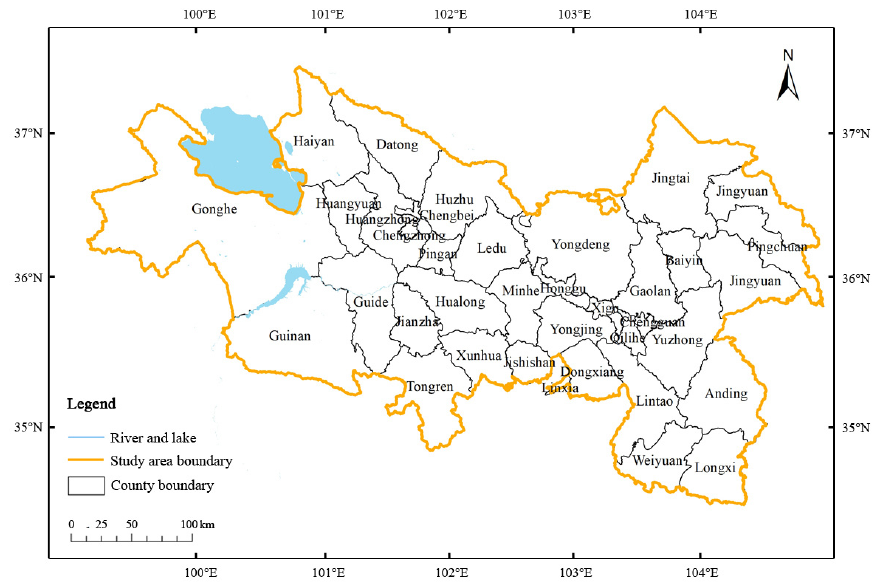
Figure 1. Map of Lanzhou-Xining urban agglomeration in the Yellow River Basin.